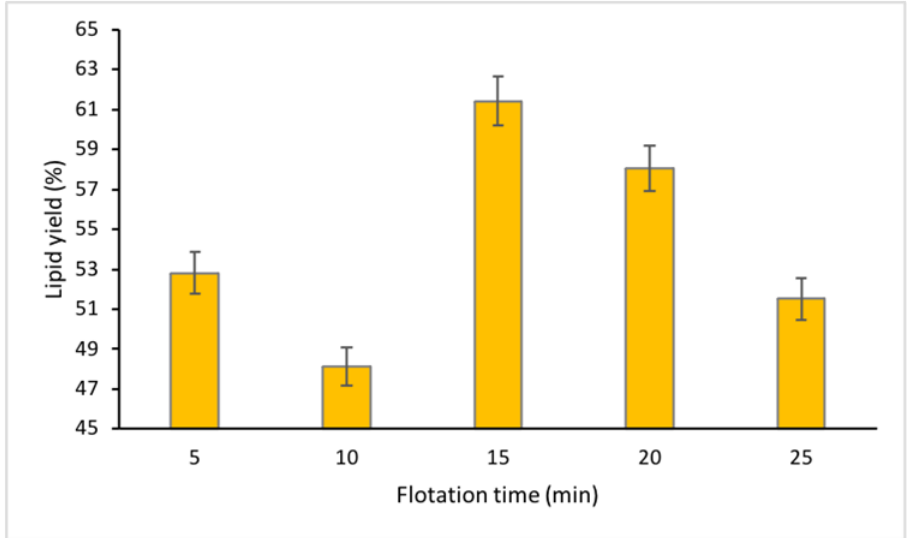
Figure 5. Percentage of lipid recovered at different flotation time .